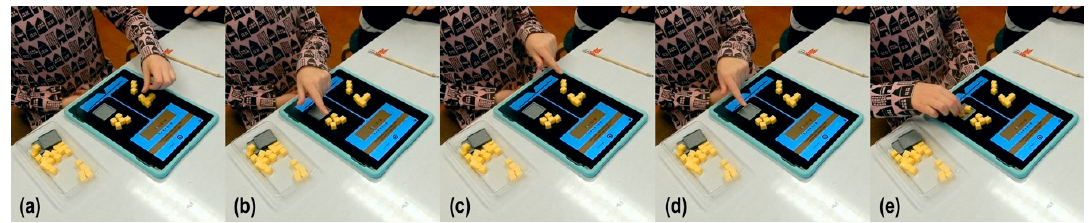
Figure 12. How one student solved an equation (8 = 1 + 4 + x) using her own invented strategy. ( a ) ‘First, I move them here’ (moving five base-10 units on the left side of the scale further away from three base-10 units on the same side); ( b ) ‘So that they’ (pointing at the five separate base-10 units on the left) ‘are equal to what is here’ (pointing at five base-10 units on the right); ( c ) ‘Then I look at here’ (pointing at three base-10 units on the bottom of the left).); ( d ) ‘They are the same [number of units] that I have to put here’ (pointing at the empty X-Box on the right); ( e ) The student then added three base-10 units to the